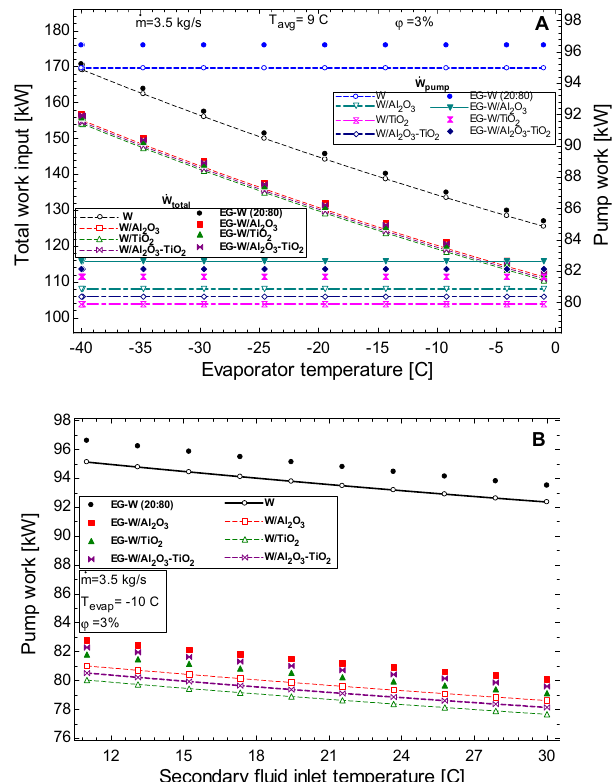
Figure 8. Effect of ( A ) evaporator temperature and ( B ) secondary fluid inlet temperature on the pump work of the